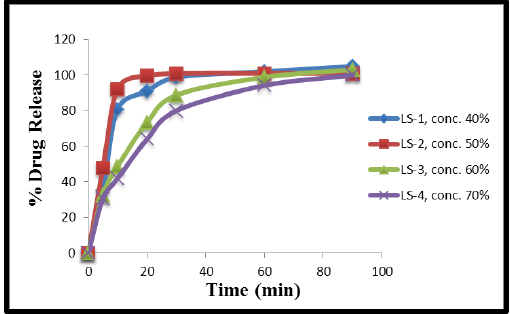
Figure 18. Effect of drug concentration on dissolution profile of clopidogrel liquisolid compacts in phosphate buffer (pH6.8) with 1%SLS at 37˚C.